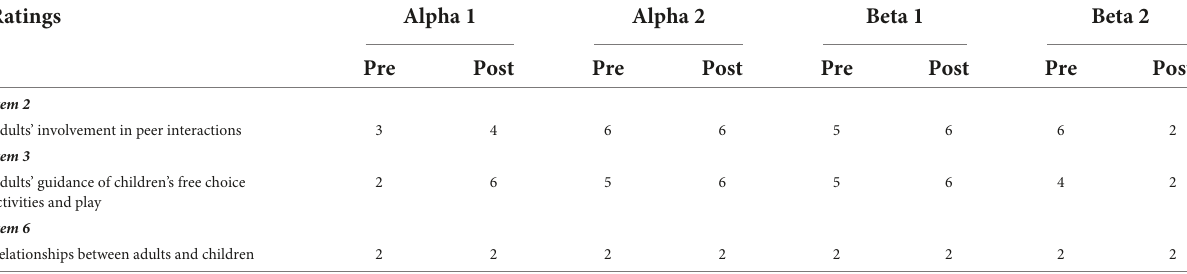
TABLE 5 Inclusion quality in observations with ICP, items 2, 3, 6, before and after the PT/ST implementation, for the preschool units.